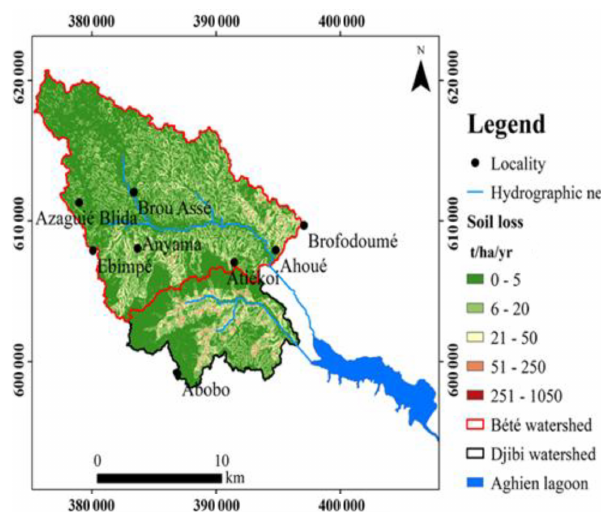
Figure 6. Soil loss in Aghien lagoon tributaries watershed